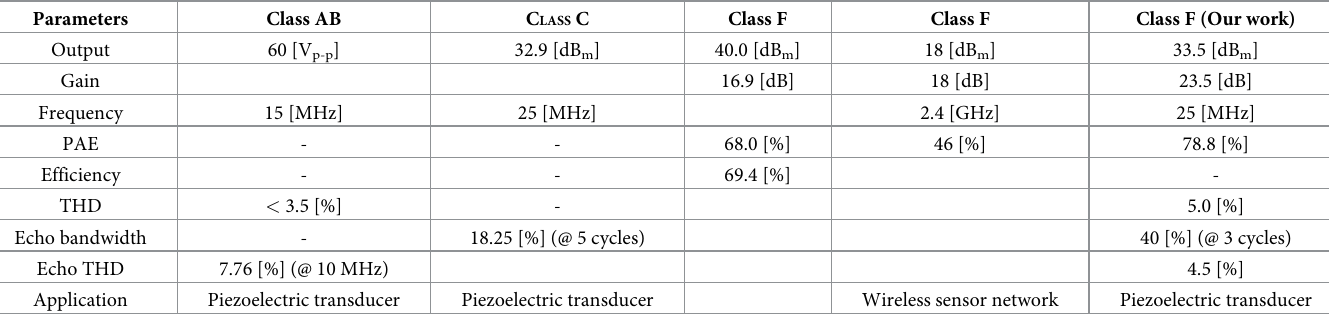
Table 3. Summarized performances of class AB amplifier [48], class C amplifier [49], class F amplifier [50,51],and our developed class F amplifier.